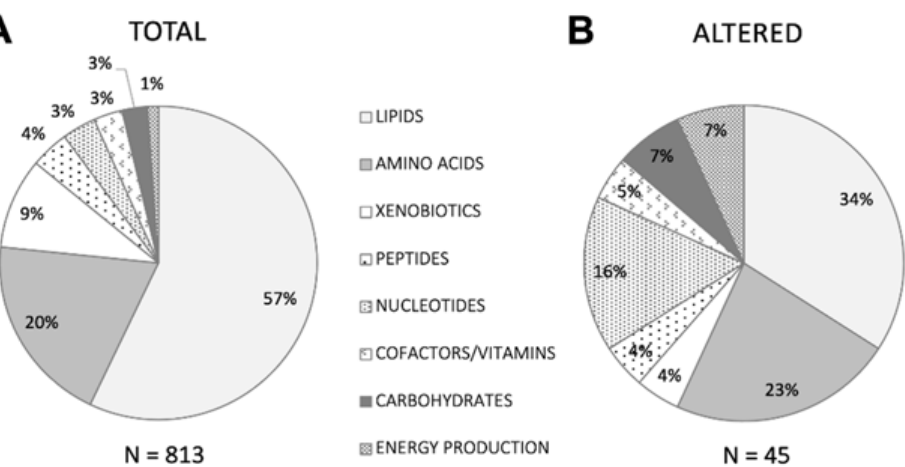
Figure 1. Pie chart depicting the proportion of biochemicals belonging to each of eight major metabolic superpathways detected in ( A ) the total passing filtering criteria among participants and reference cohort individuals, and ( B ) the subset meeting altered criteria among participants compared to the reference cohort, as described in Methods.